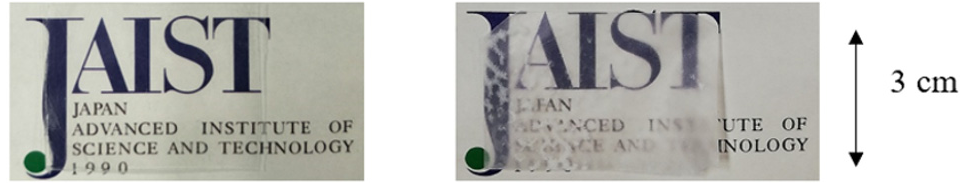
Figure 2. Photographs of the films with 200 µ m thickness: PVA/Mg(ClO 4 ) 2 ( left ) and PVA/MgSO 4 ( right ). Each film had a salt content of 0.05 as a molar ratio relative to the quantity of PVA hy- droxyl groups.